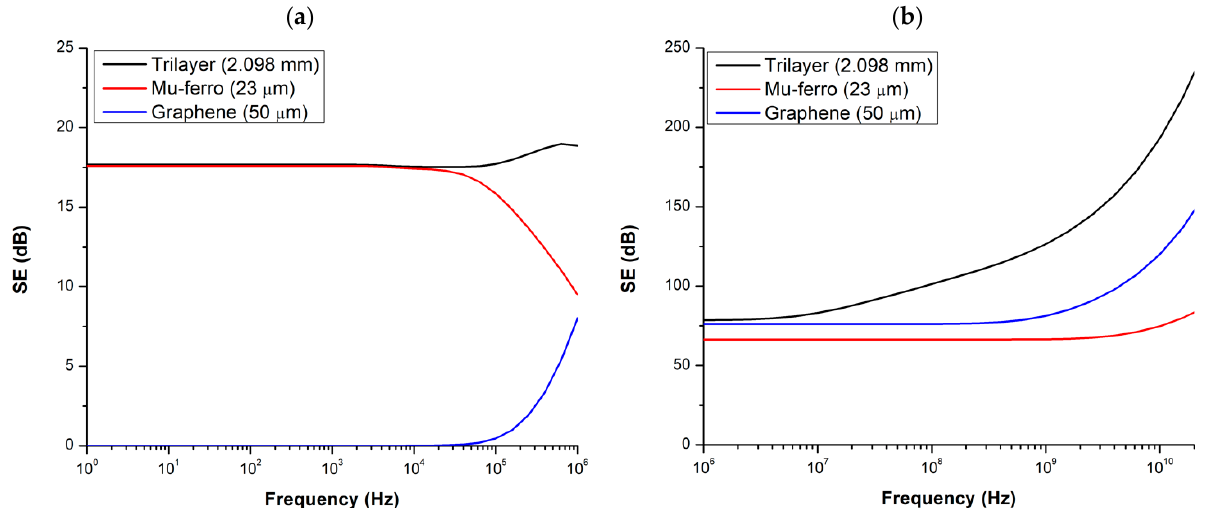
Figure 5. Shielding effectiveness of the trilayer composite (black), the graphene layer (blue), and the mu ‐ ferro layer (red) obtained with the numerical model in the near ‐ field ( a ) and far ‐ field ( b ).